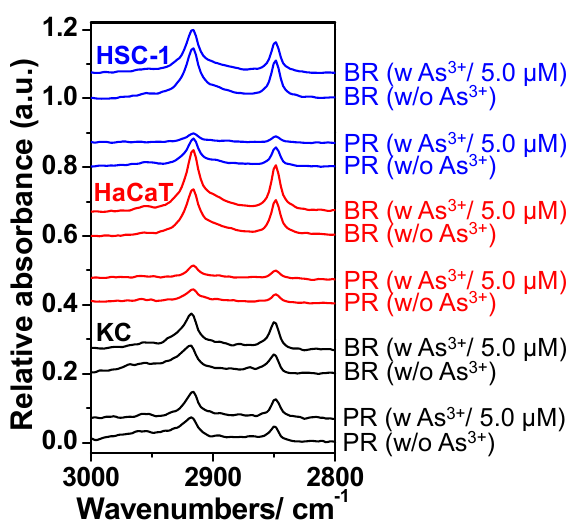
Figure 4. Characteristic IR absorbance of n-pentacosane remaining (PR) and beeswax remaining (BR) adhered on cell samples with ( w ) and without ( w / o ) sodium arsenite (As 3+ ) exposure after a dewaxing procedure via xylene washing, using the WPK-FPA-FTIR imaging technique. The IR absorbance spectrum data was determined relative to that of the corresponding non-waxed cell sample.